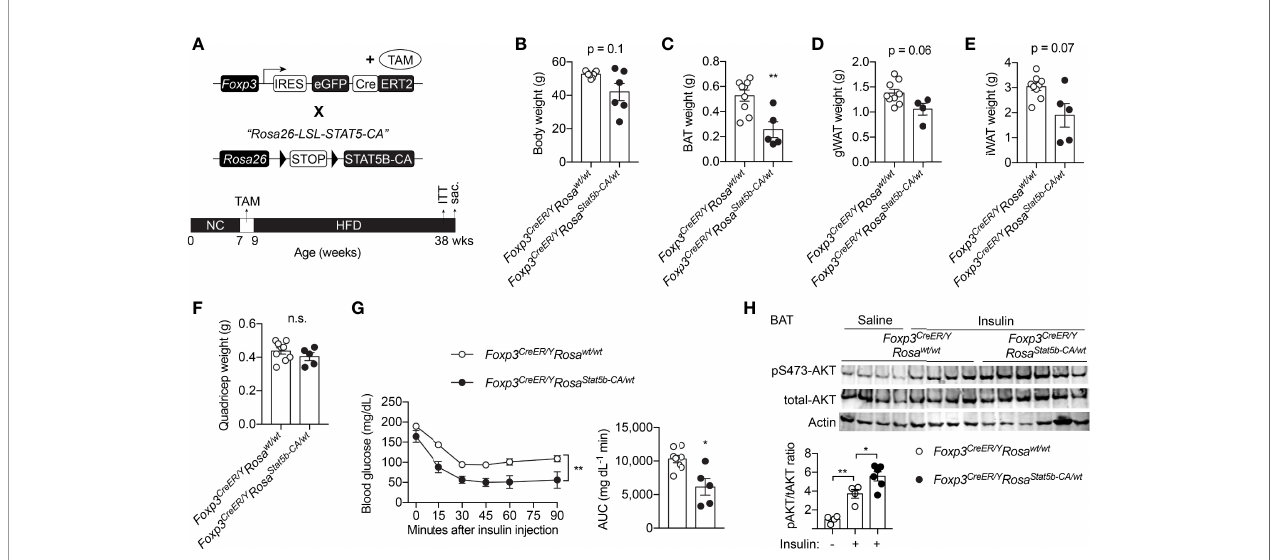
FIGURE 5 | Inducible STAT5B-CA expression in Treg cells promotes metabolic adaptation to HFD. (A) Schematic view of the generation of tamoxifen-inducible, Treg cell-speci fi c STAT5B-CA overexpression mice and dietary regimens to the mice. (B) Body weight of HFD-fed Foxp3 eGFP-Cre-ERT2/Y (n = 6) and Foxp3 eGFP-Cre- ERT2/Y Rosa26 Stat5b-CA/wt (n = 6) mice. (C – F) Weight of BAT (C) , gonadal WAT (D) , inguinal WAT (E) , and quadricep muscle (F) of Foxp3 eGFP-Cre-ERT2/Y (n = 9) and Foxp3 eGFP-Cre-ERT2/Y Rosa26 Stat5b-CA/wt (n = 5) mice. (G) Insulin tolerance test of HFD-fed Foxp3 eGFP-Cre-ERT2/Y (n = 8) and Foxp3 eGFP-Cre-ERT2/Y Rosa26 Stat5b-CA/wt (n = 5). Area under curve (AUC) is shown to the right. (H) pS473-Akt and total-Akt immunoblotting of BAT protein lysates from Foxp3 eGFP-Cre-ERT2/Y and Foxp3 eGFP-Cre- ERT2/Y Rosa26 Stat5b-CA/wt mice treated with saline or insulin for 30 min. Data are presented as mean ± SEM. n.s., not signi fi cant; *, p < 0.05; **, p < 0.01 by unpaired student ’ s t-test, one-way or two-way